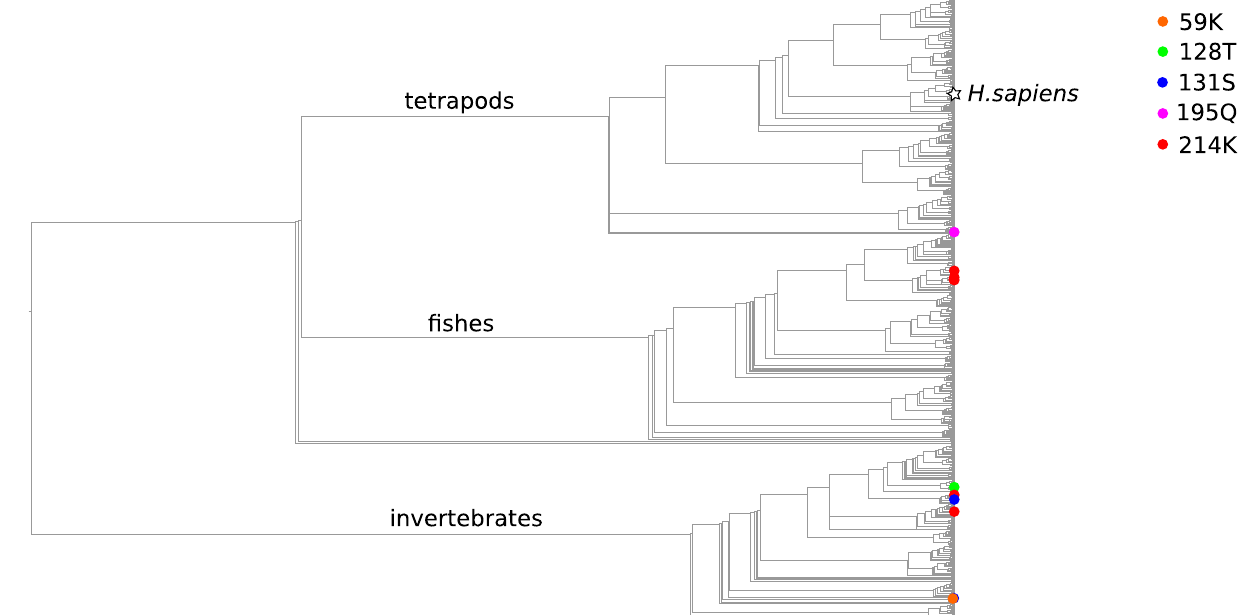
Figure 1. Substitutions to human pathogenic amino acids in sites of ND1 across the cladogram of Metazoa. White star, human branch.